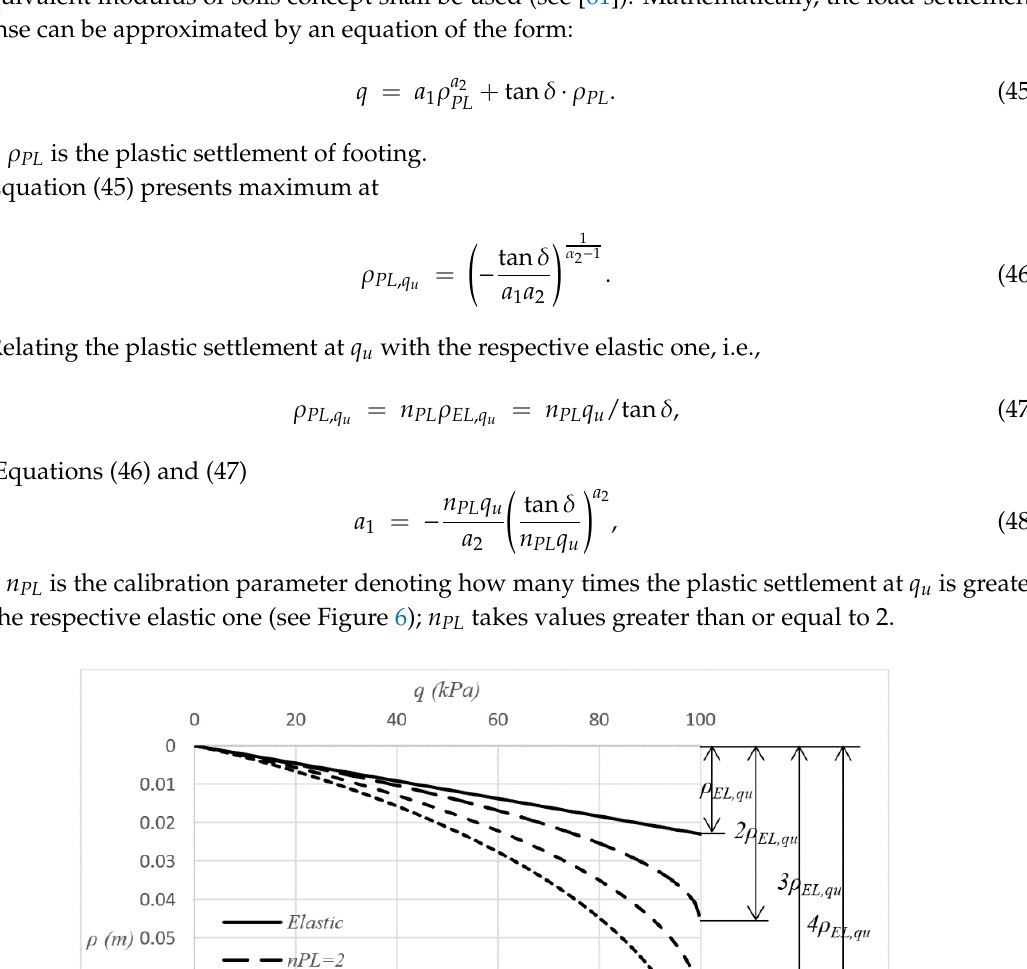
Figure 6. Proposed approach for non-elastic response of soil; n PL can be any positive real number greater than 2.